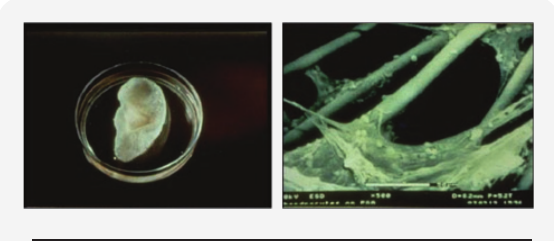
Figure 7. Scaffold of Human Ear, Left Panel Scanning electron micrograph of polymer fi bers and cells, Right Panel.